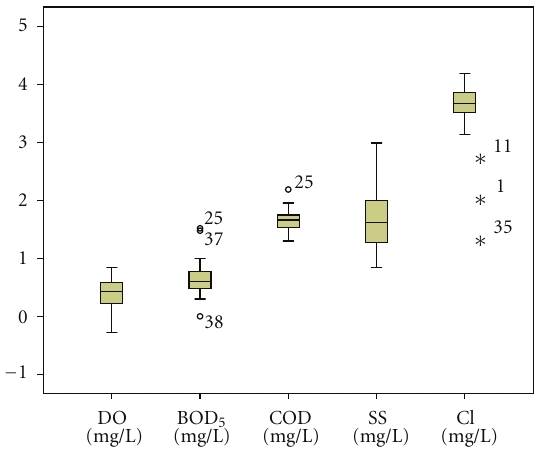
Figure 2: Box and whisker plot of discriminant parameters in wet season (forward stepwise).